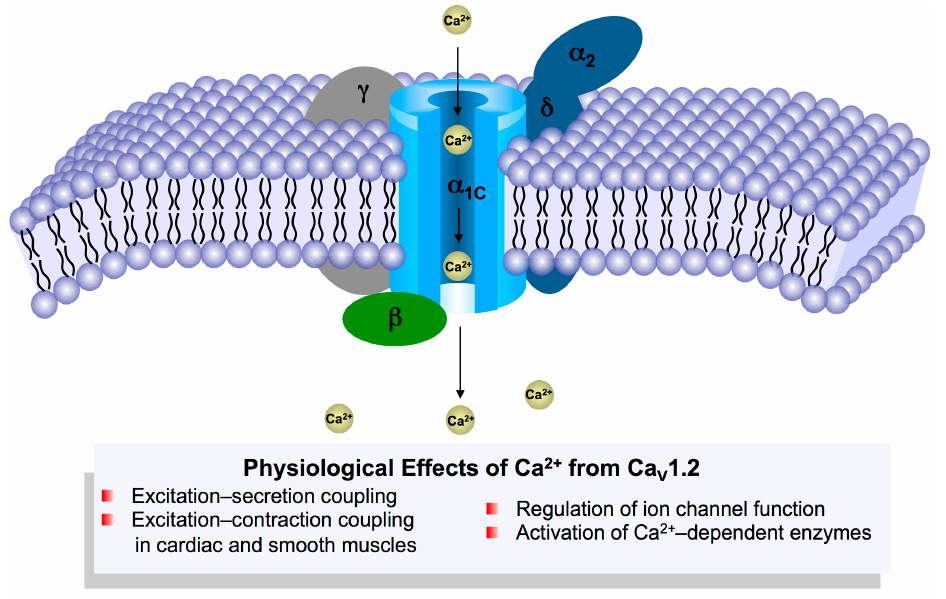
Figure 1. Subunit assembly of the Ca V 1.2 protein complex and the major physiological effects of Ca 2+ entry into the muscle cells through Ca V 1.2 channels.